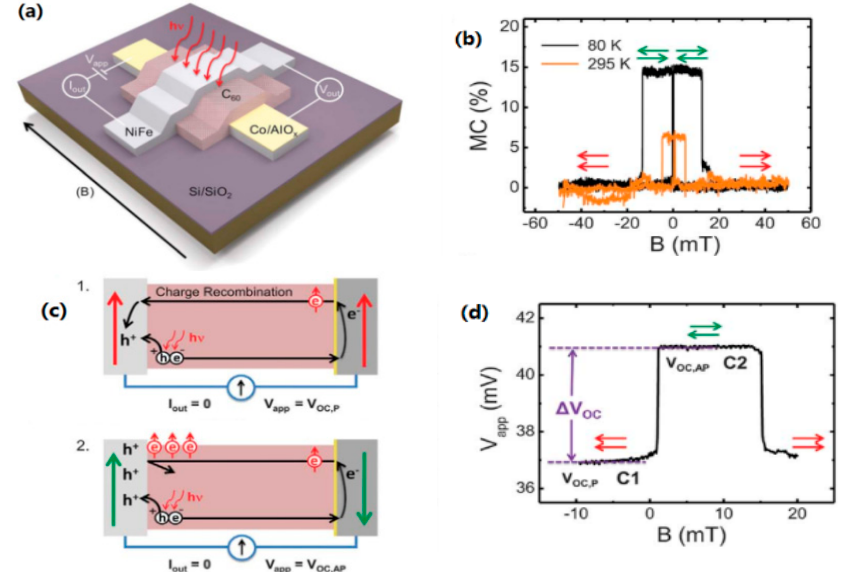
Figure 11. Illustration of a spin-photovoltaic device. ( a ) A schematic diagram of the spin-photovoltaic device. ( b ) The MC effect measured at 80 and 295 K with a bias of 10 mV in dark condition. MC = (I P − I AP )/I AP × 100%, where I P and I AP represent the parallel and antiparallel case of two electrodes. ( c ) Function principle of the spin-photovoltaic device in open circuit mode under an external magnetic field. ( d ) Bias voltage versus magnetic field at 80 K in open-circuit mode. Adapted from [117], with permission from © 2017 The American Association for the Advancement of Science.